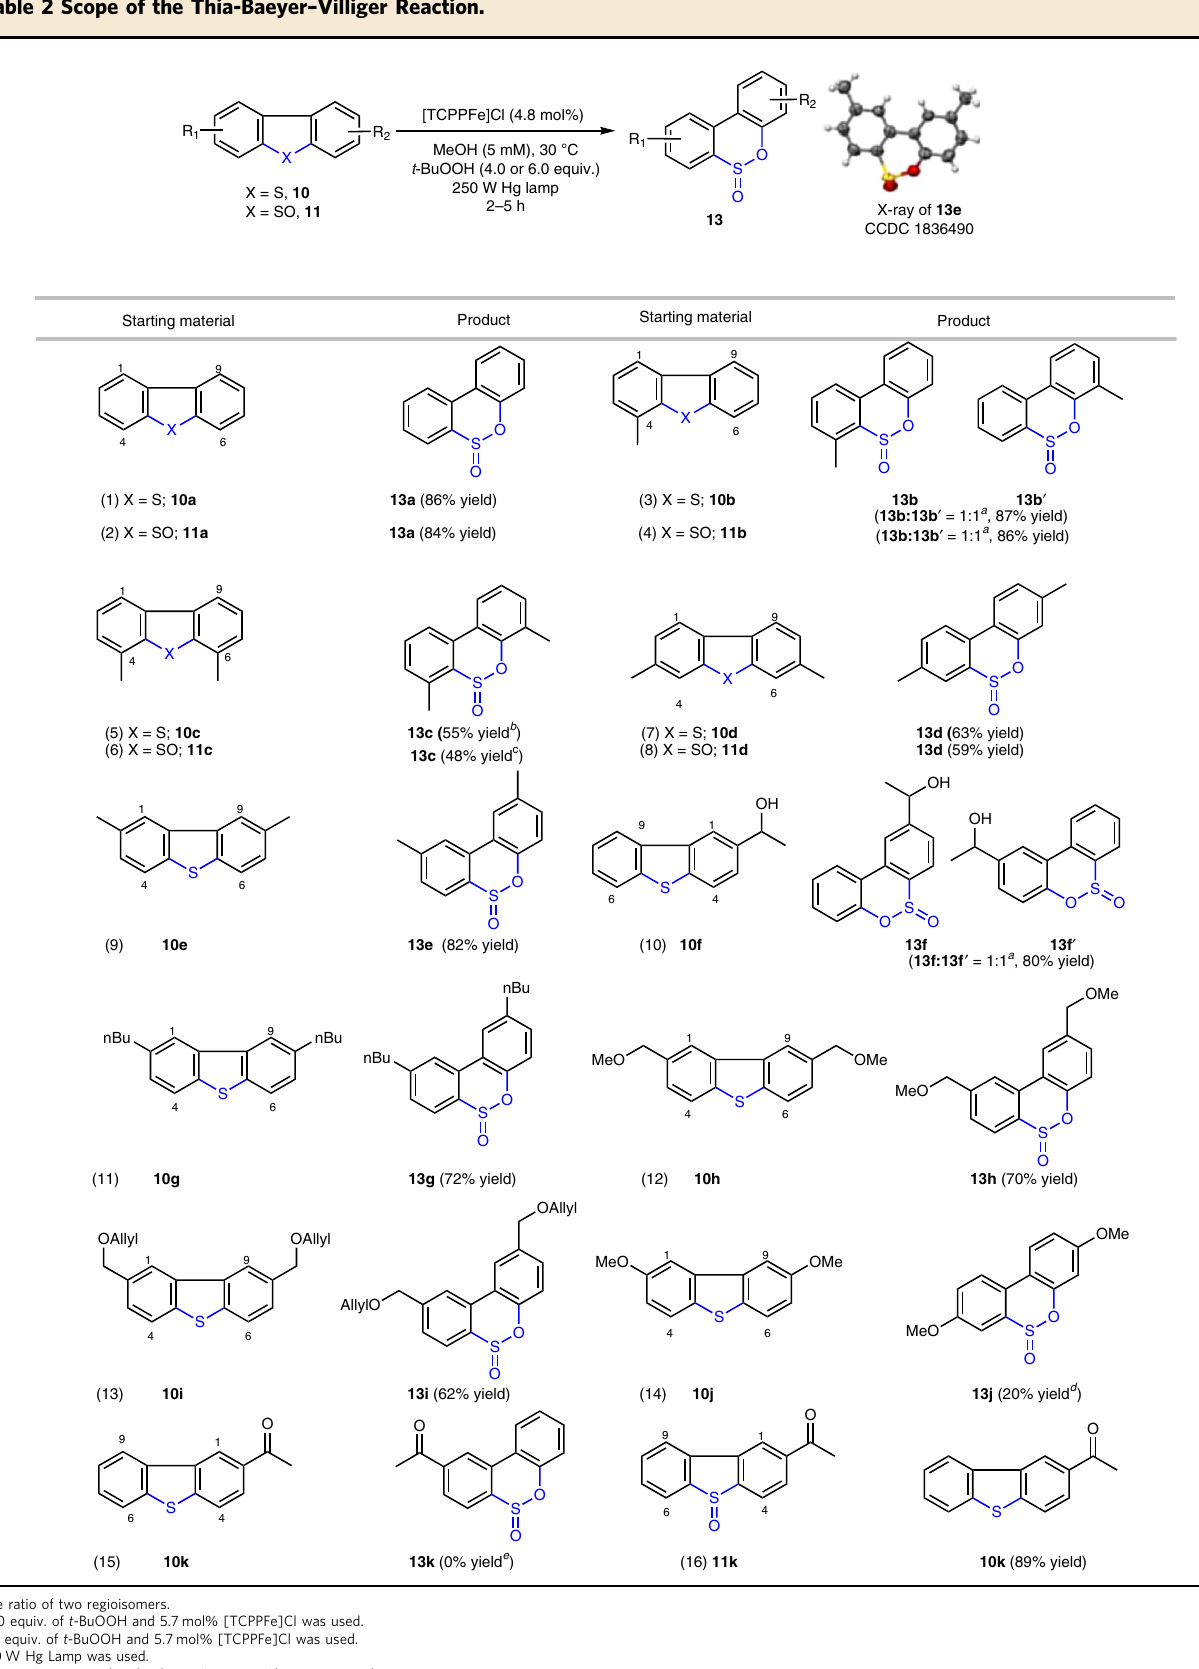
Table 2 Scope of the Thia-Baeyer – Villiger